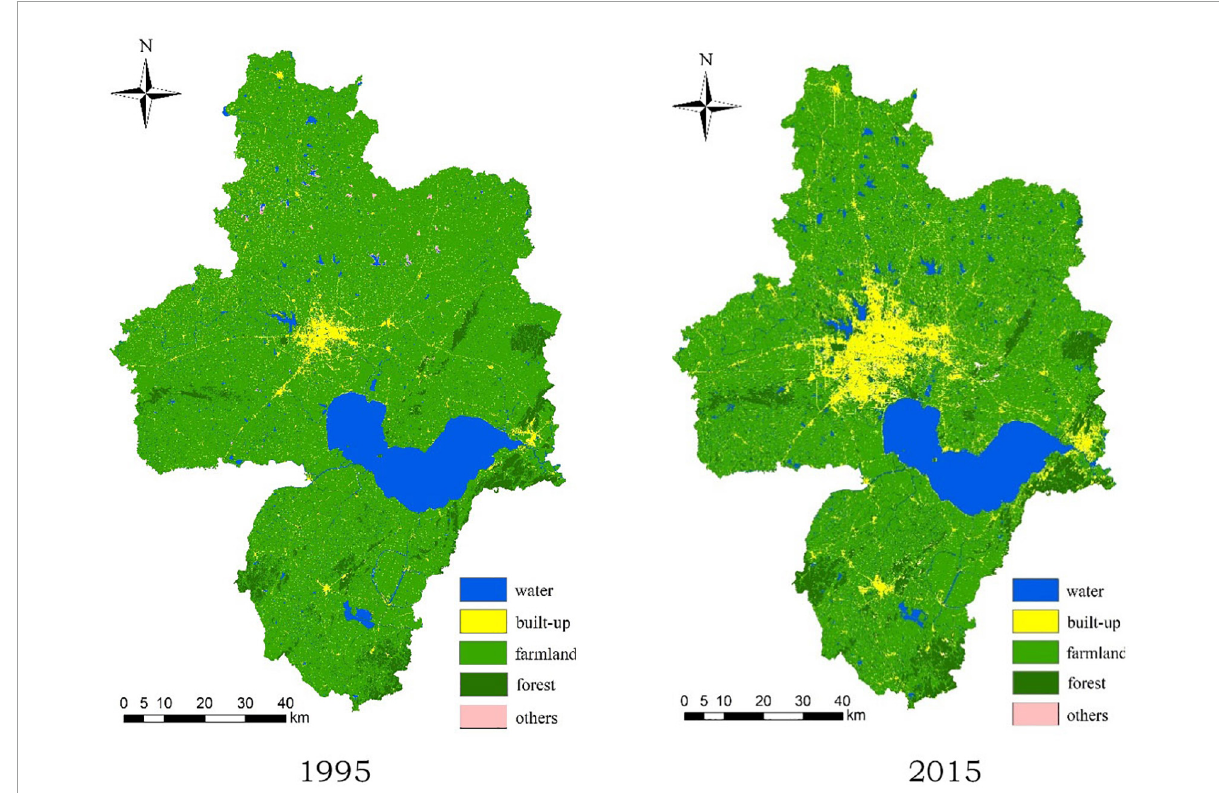
FIGURE3 Spatial pattern of urban green space in 1995 and 2015.